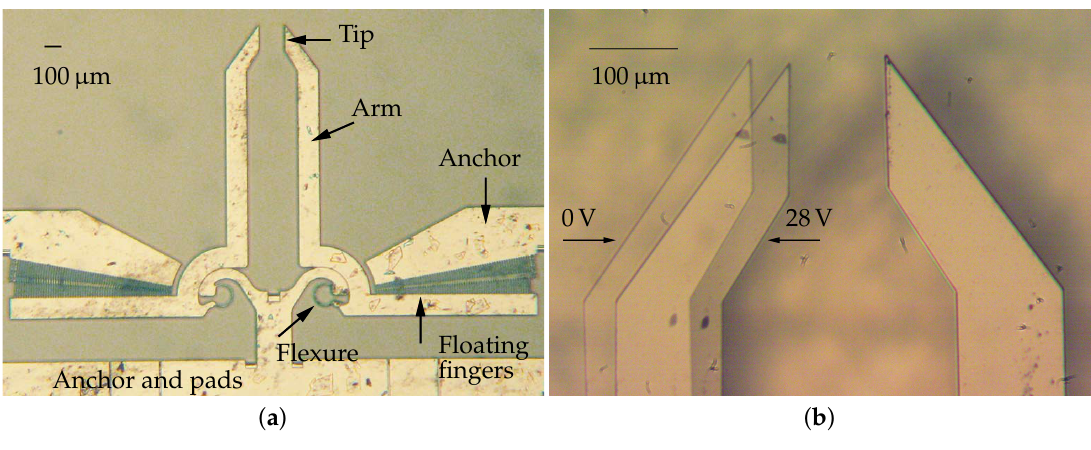
Figure 1. Optical microscope images of the device. The whole microgripper ( a ) and two overlapping frames showing the left arm in neutral (0V) and actuated (28V) configurations ( b